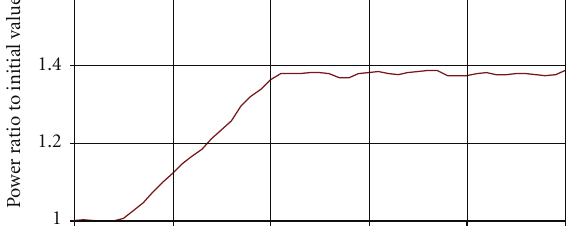
Table 8: Void fraction standard deviations for all steady state test cases.